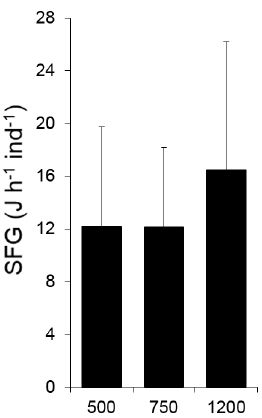
Fig. 4. Scope for growth (SFG) of the mussel Choromytilus chorus exposed to contrasting p CO 2 levels. Bars correspond to means ±1